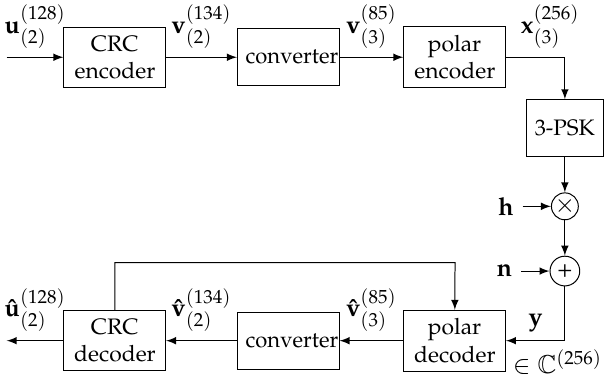
Figure 9. Transmission chain with binary source, cyclic redundancy check (CRC)-aided polar code and 3-PSK. Subscripts indicate the alphabet size, superscripts indicate the length of the vectors.